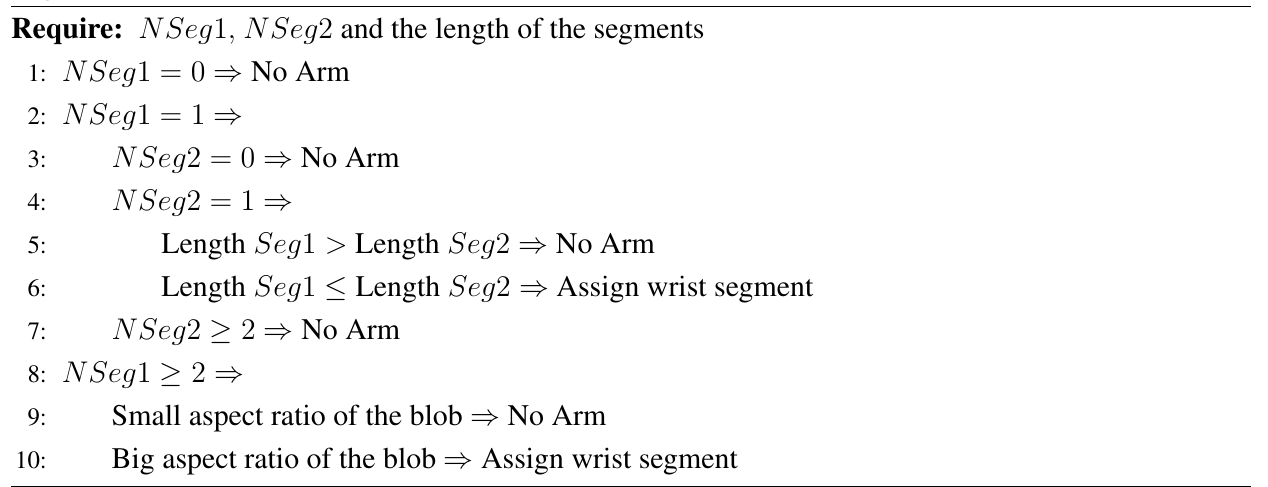
Algorithm 3 Arm and Wrist